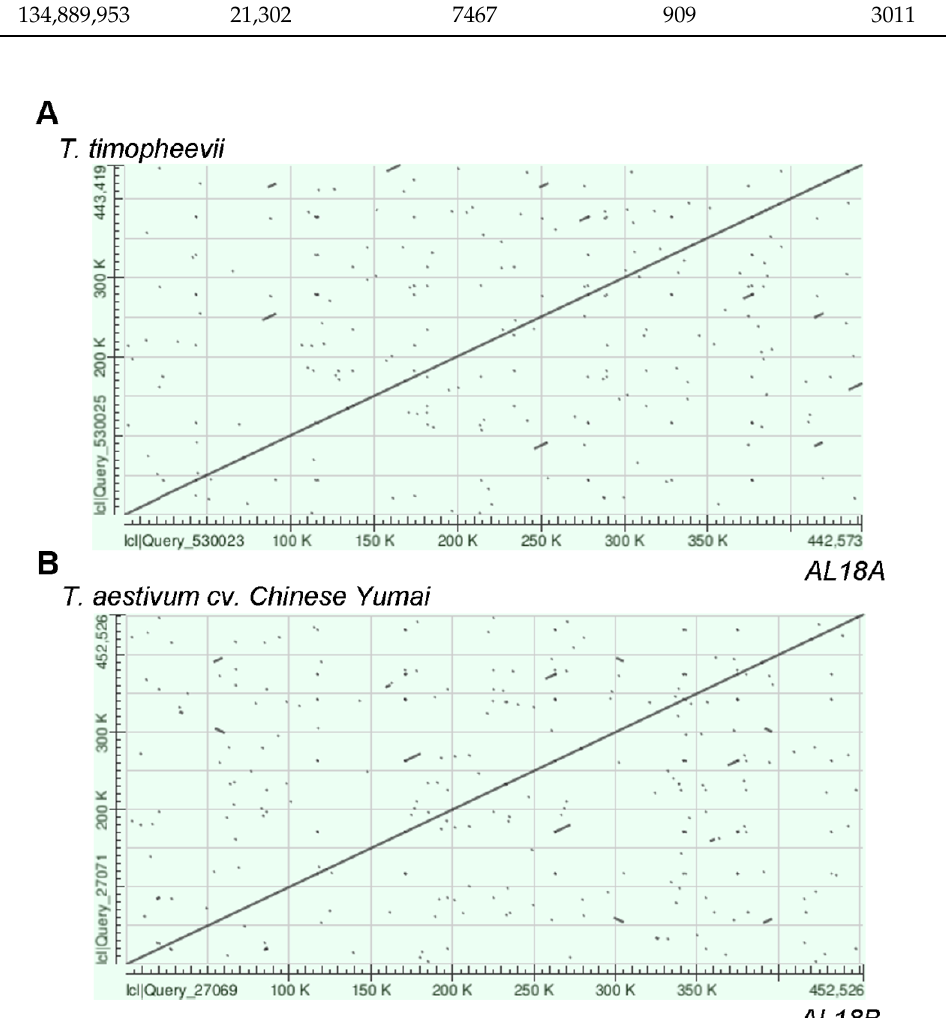
Figure 2. Comparison of mitochondrial DNA between AL18A and Triticum timopheevii ( A ), AL18B and Chinese Yumai ( B ). ( A ) The abscissa represents the mitochondrial DNA sequence of AL18A, and the ordinate represents the mitochondrial DNA sequence of Triticum timopheevii . ( B ) The abscissa represents the mitochondrial DNA sequence of AL18B, and the ordinate represents the mitochondrial DNA sequence of Chinese Yumai.